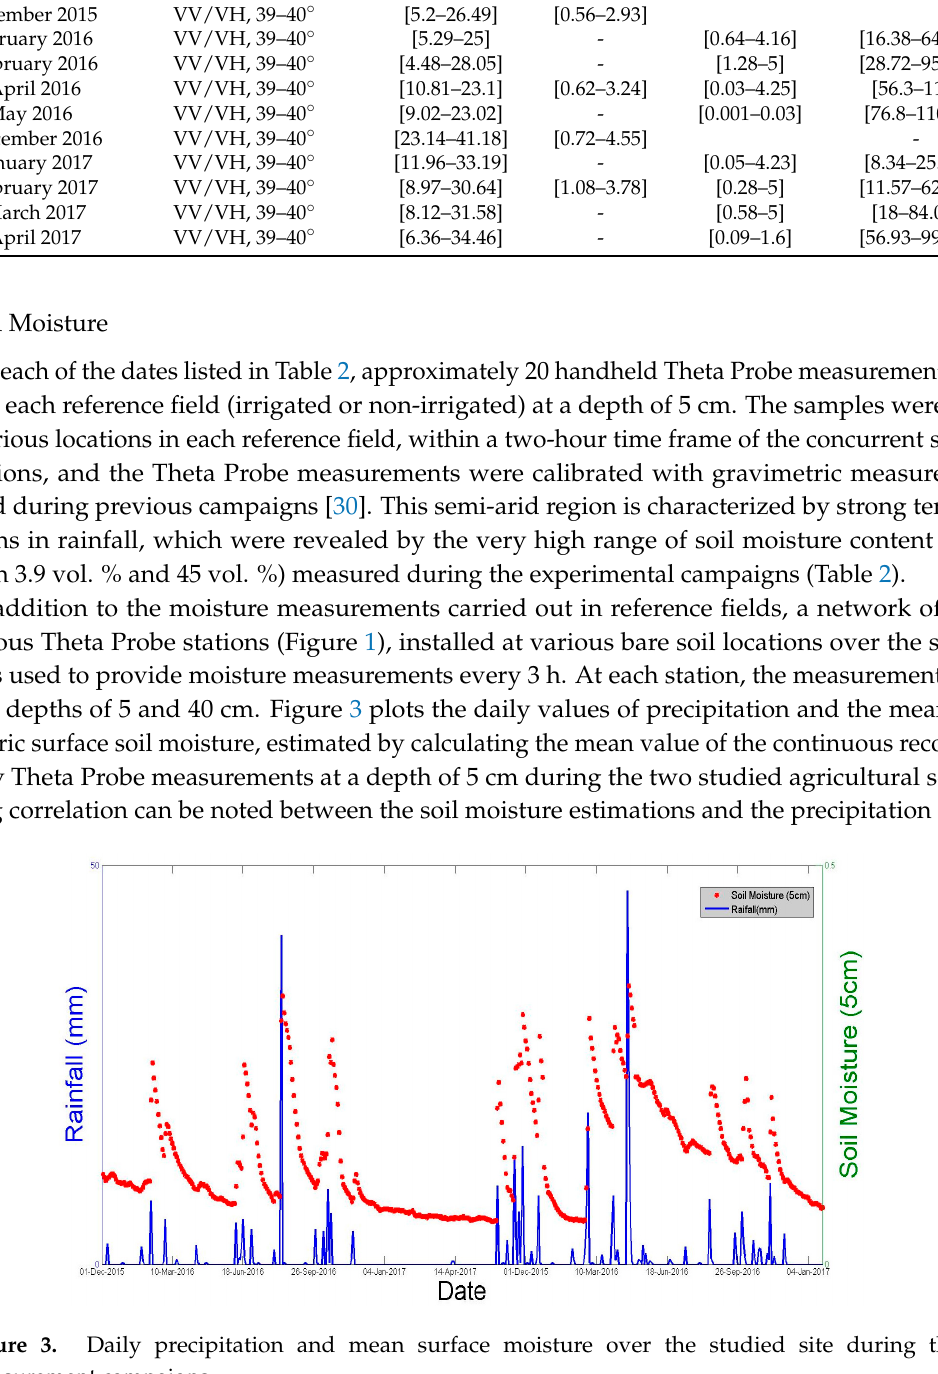
Table 2. Radar and ground measurement campaigns during 2015–2017. Radar image configurations;